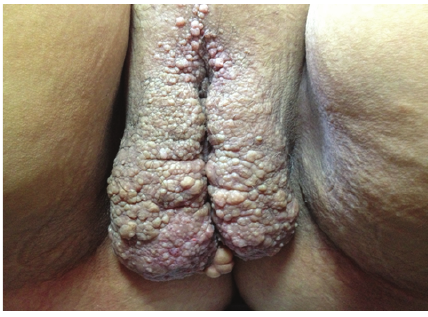
Figure 4: Large verrucous lesions covering the labia